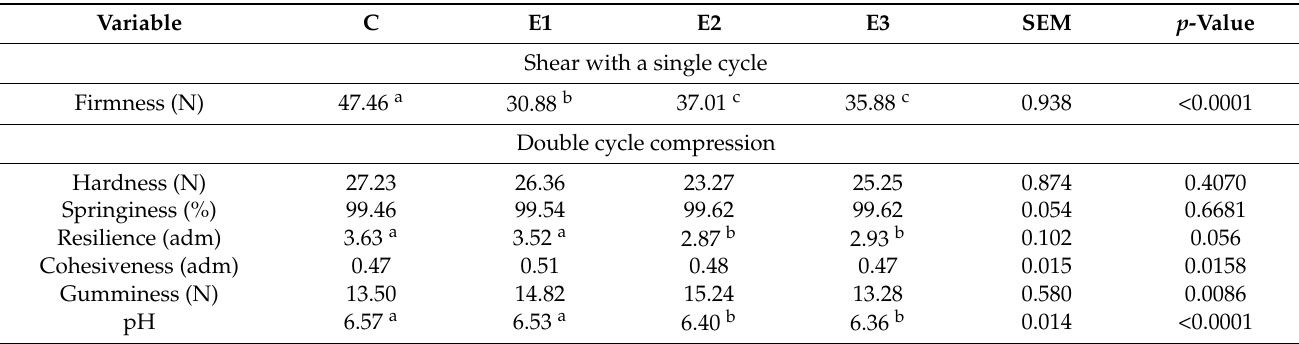
Table 5. Texture parameters of thigh meat.